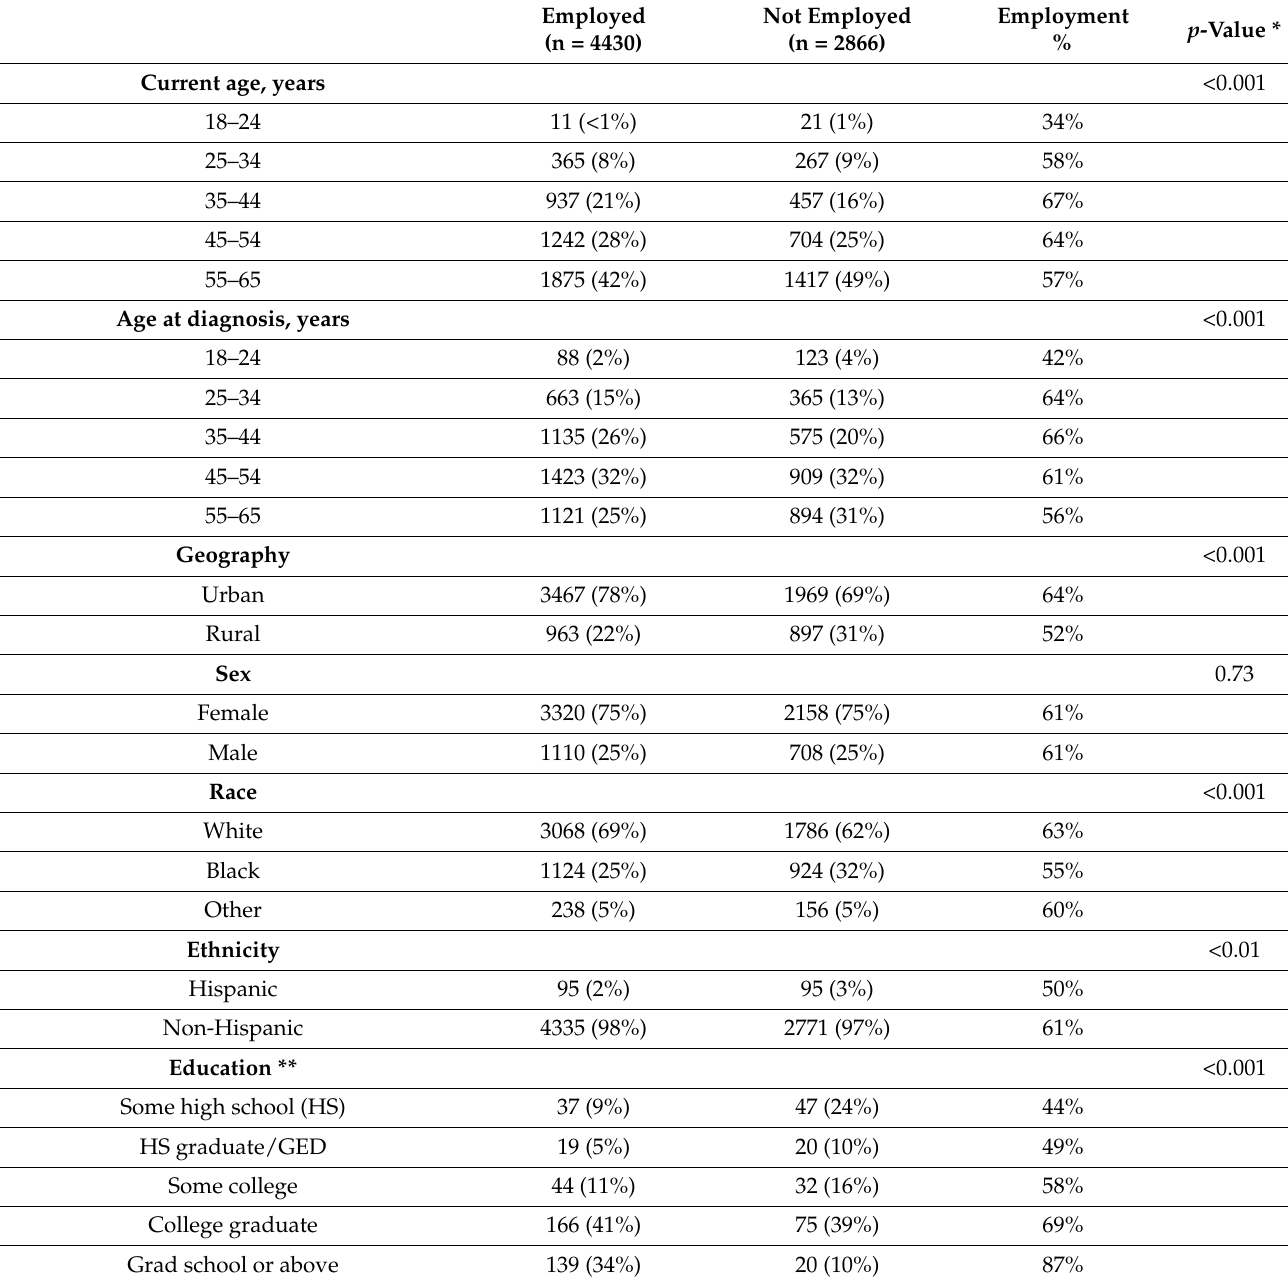
Table 1. Characteristics of cancer patients by employment